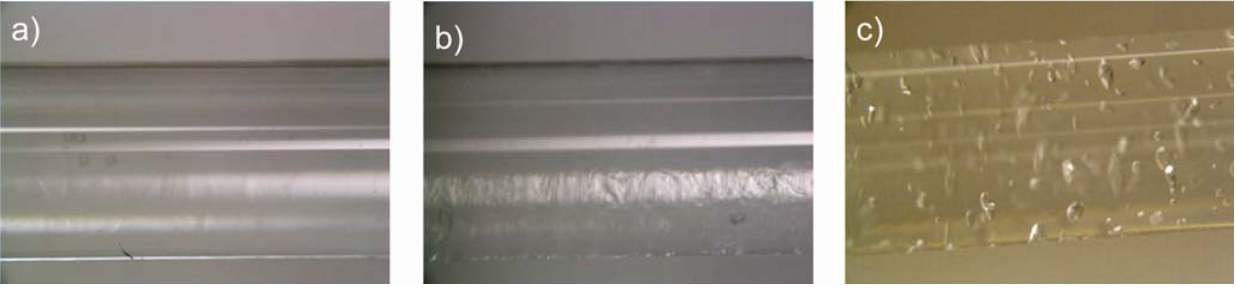
Figure 6 . Representative photographs of hydrogels swollen in 2 mm diameter glass capillaries with deionized water. (a) Cabloc CT, (b) Produkt Z 1069, and (d) Favor pac 230. White lines on the tubes are reflections on the glass from the lamp used to illuminate the samples.